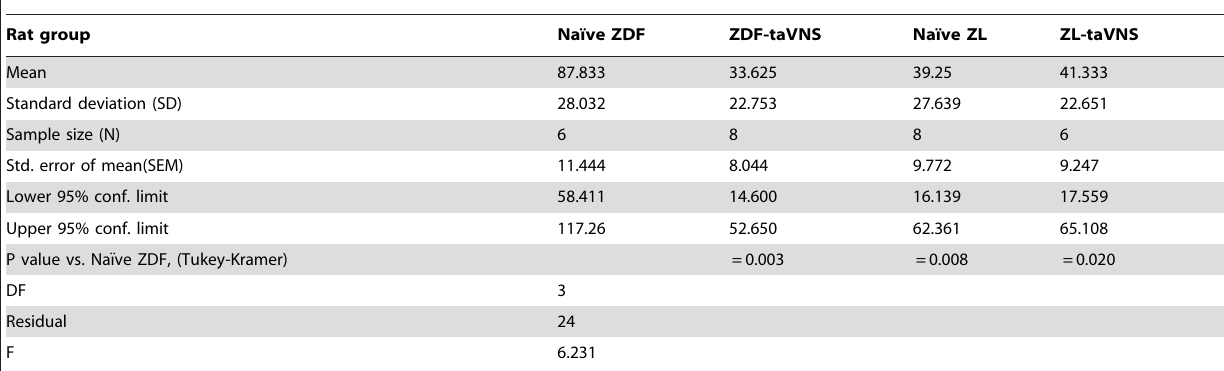
Table 2. Immobility time in rats on day 35.